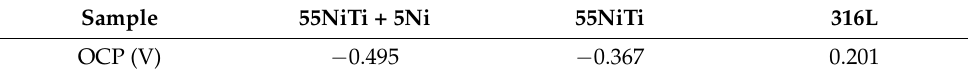
Figure 10. Open-circuit potential (OCP) curves of 2 h in 3.5 wt.% NaCl solution. Table 4. The stable open-circuit potential of the substrate and coatings.